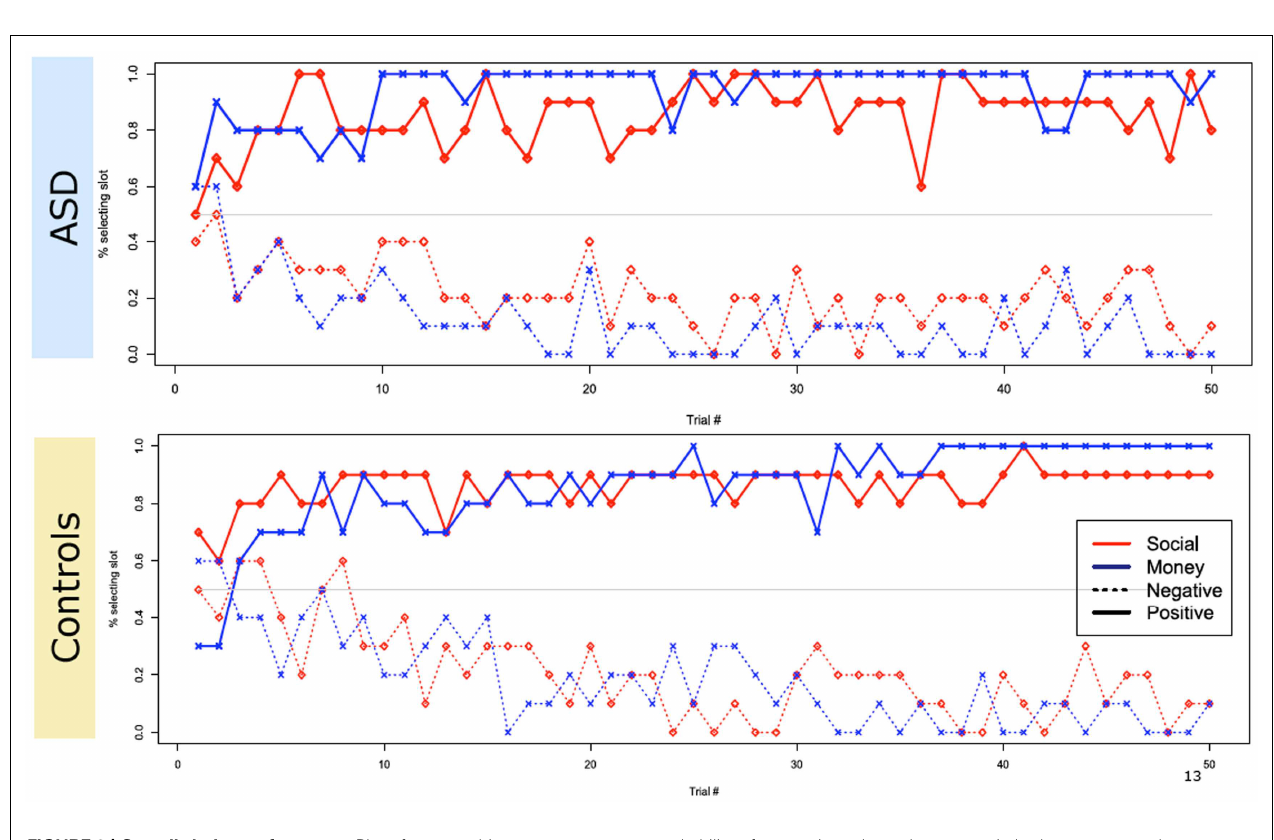
FIGURE 3 | Overall choice performance. Plot of group subject choices across trials. Both groups reliably learned to select the slot machine associated with the highest probability of a positive-valenced outcome and avoid the slot machine associated with the highest